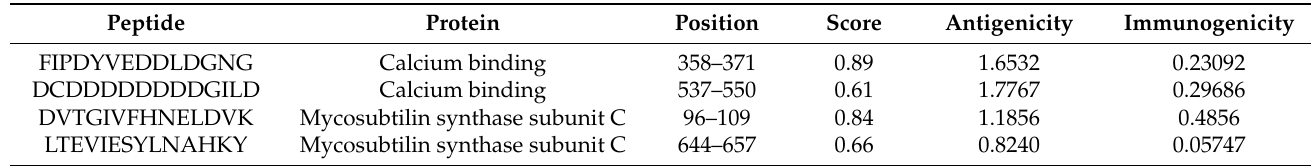
Table 4. Screened LBL epitopes for MEV construction.